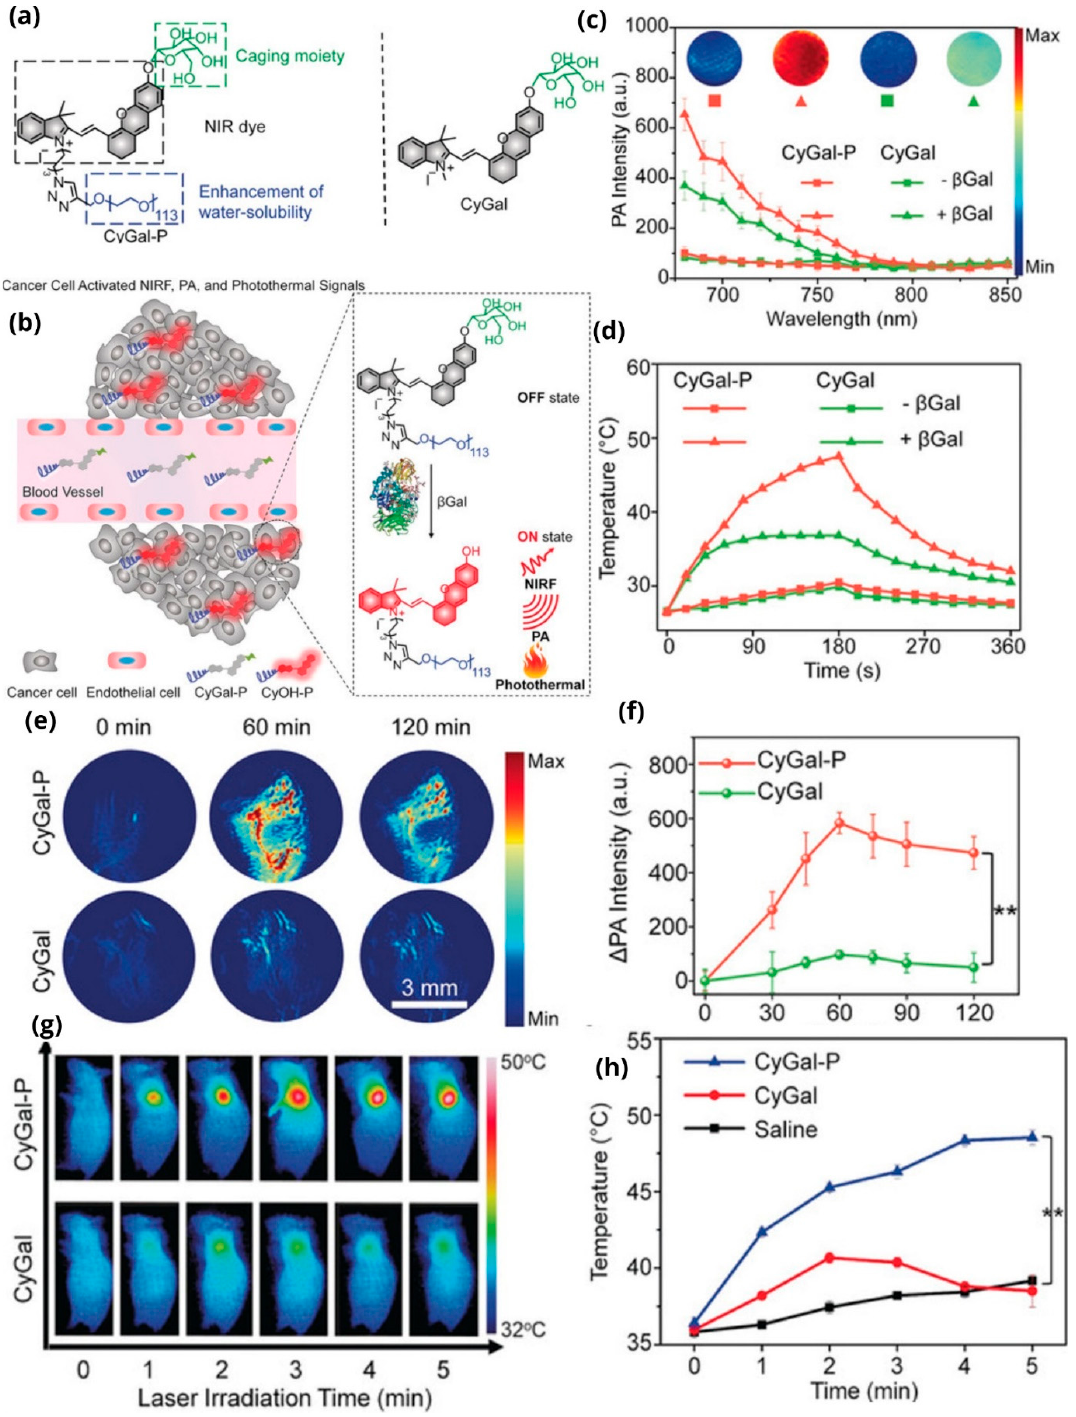
Figure 13. ( a ) Structures of the macrotheranostic probe (left) and the control probe without PEG (right); ( b ) schematic representation of the activation mechanism of the macrotheranostic probe; ( c ) the PA spectra of the probes in the presence or absence of β Gal at 37 ◦ C in vitro; ( d ) the temperature of the probes in the presence or absence of β Gal after laser irradiation at 680 nm in vitro; ( e ) PA images of SKOV3 tumor-bearing living mice after in vivo injection of the probes; ( f ) PA intensity increment ( ∆ PA680 is denoted by a double star “**”) of CyGal-P and CyGal in SKOV3 tumor-bearing living mice; ( g ) IR thermal images in vivo after laser irradiation at 680 nm; and ( h ) diagrammatic representation of the photothermal phenomenon (Temperature intensity change is denoted by a double star “**”of CyGal-P and CyGal). Adapted with permission from [128], John Wiley and Sons,